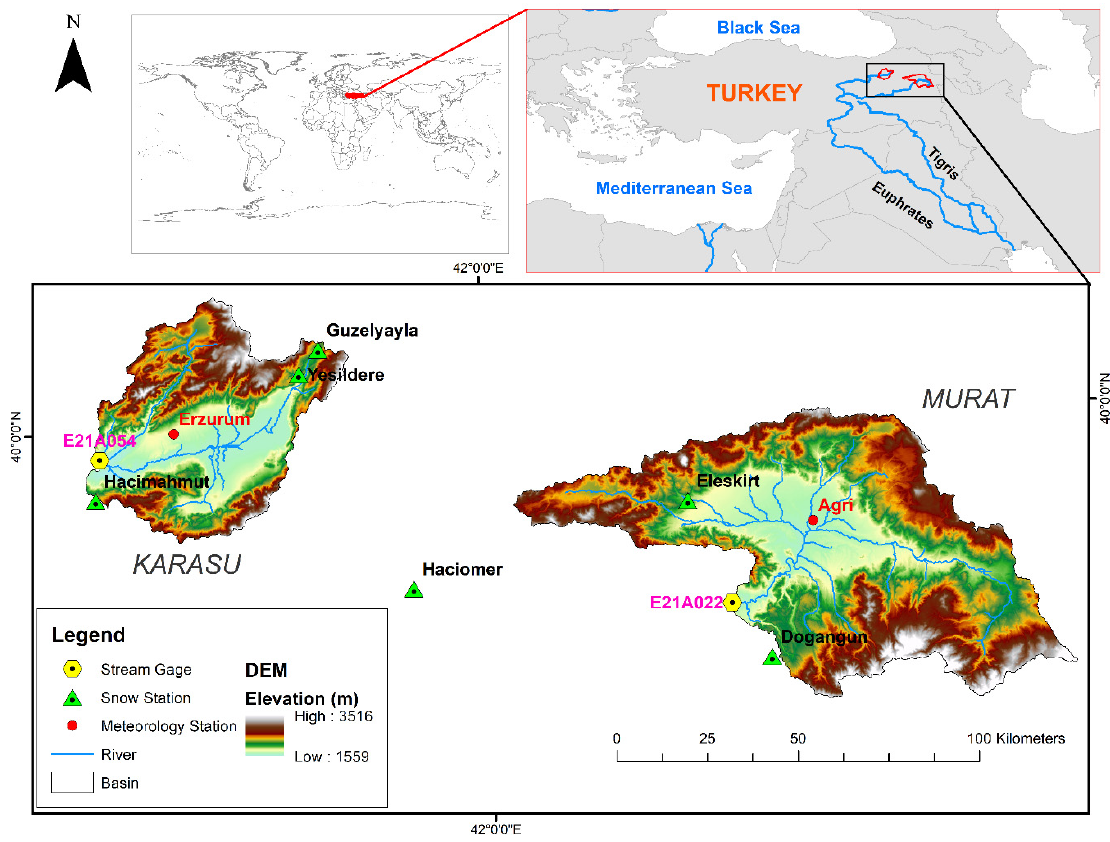
Figure 1. Geographic location of Murat and Karasu basins.